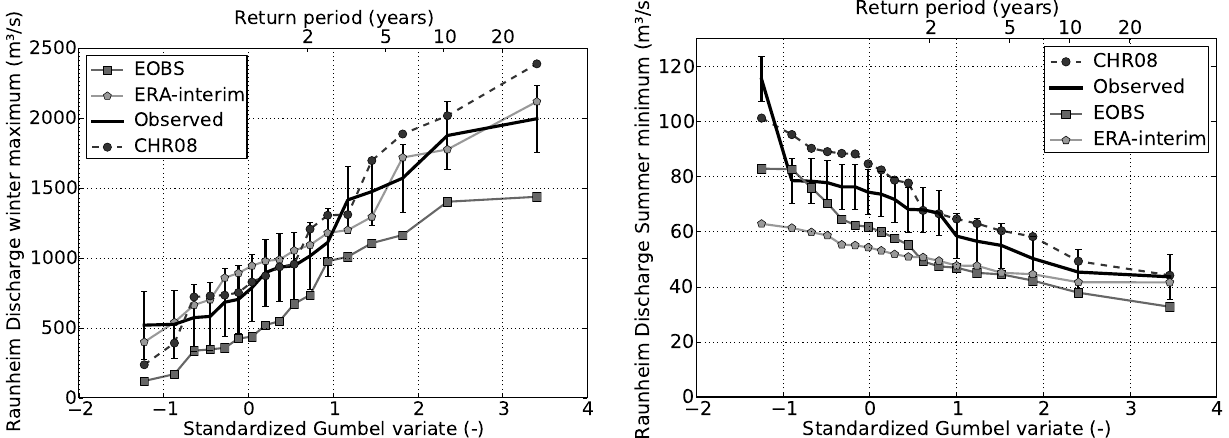
Fig. 8. Gumbel plot for CHR08, E-OBS, ERA-Int and observed winter maximum (left panel) and summer minimum (right panel) discharges and the 95% confidence interval for the observed discharges at Raunheim for the period 1990–2008.